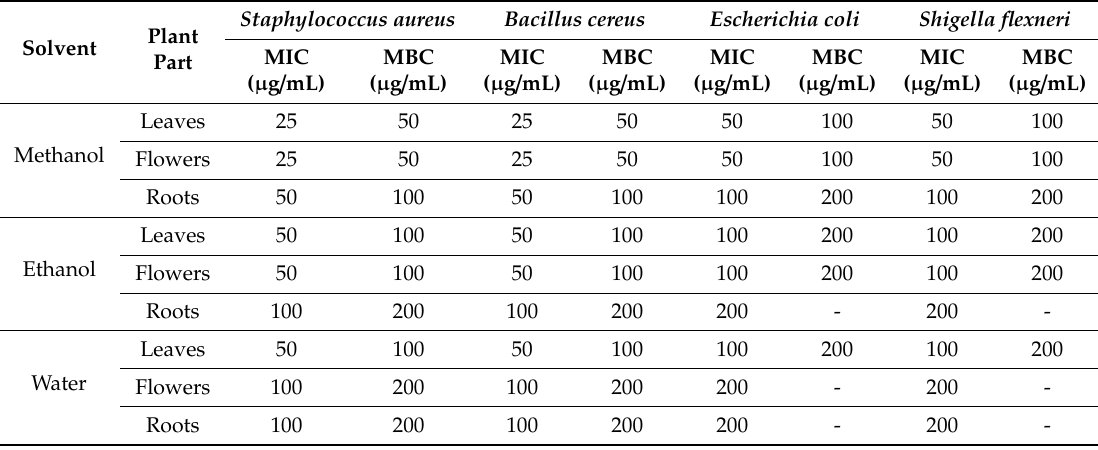
Table 5. Minimum inhibitory concentration (MIC) and minimum bactericidal concentration (MBC) values of the Nepeta juncea extracts against the tested